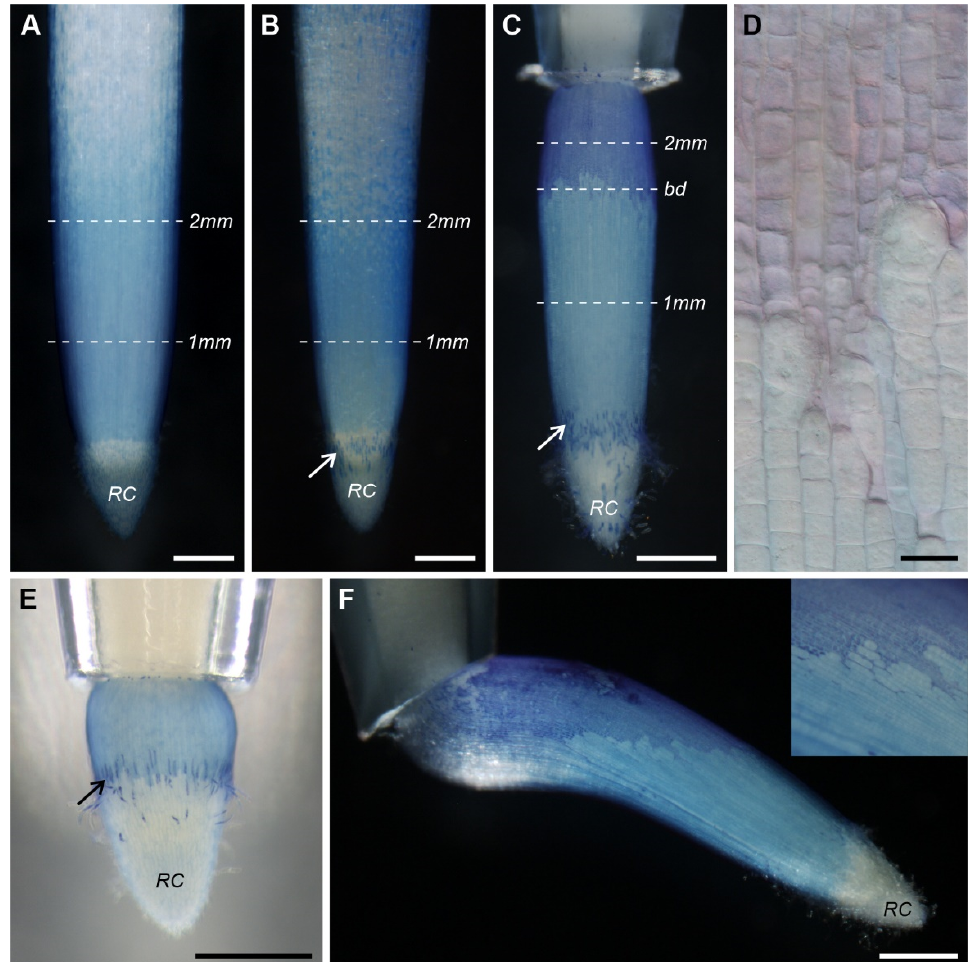
Figure 4. Overall view of the C, S and R root tips dyed with Evans Blue ( A – C , respectively). Dashed lines indicate the level of cross sections shown in Figures 5 and 7, see Materials and Methods. ( D ) Magnified view of the R root surface showing the irregular character of the boundary (bd) separating two regions of different shades of stain. ( E ) Evans Blue-stained recovering root whose apex has just left the tube ending; notice the lack of an area of dark blue staining. ( F ) Evans Blue-stained recovering root growing out of the tube with obliquely cut ending and magnified view of the root surface (upper right corner). Arrows in ( B , C , E ) point to dead cells of the root cap (RC). Scale bars: 0.5 mm ( A – C , E , F ), 20 μm ( D ).